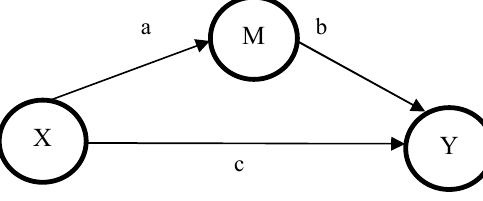
Fig. 3. Mediation analysis (Zhao et al .,